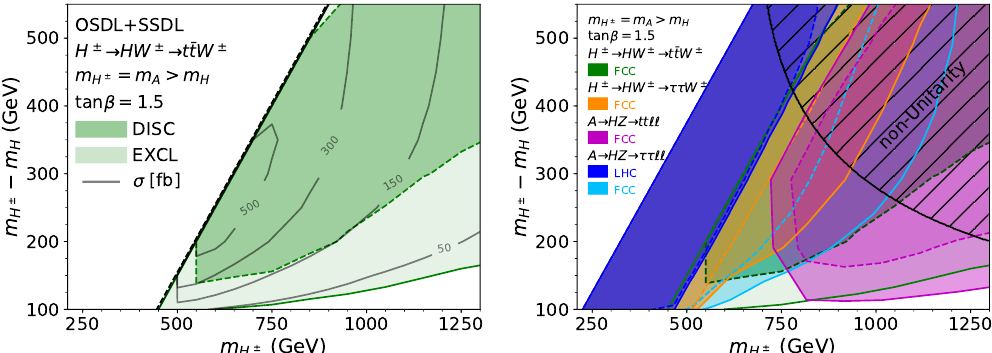
Figure 4 . The left panel shows the discovery and exclusion reach of charged Higgs via H ± → HW ± → t ¯ tW ± in m vs. m − m H plane at 100 TeV pp collider with L = 3000 fb − 1 . Color H ± H ± coding is the same as in figure 3. The right panel shows the reaches of H ± → HW ± → t ¯ tW ± as well as other exotic channels [18]. See text for more